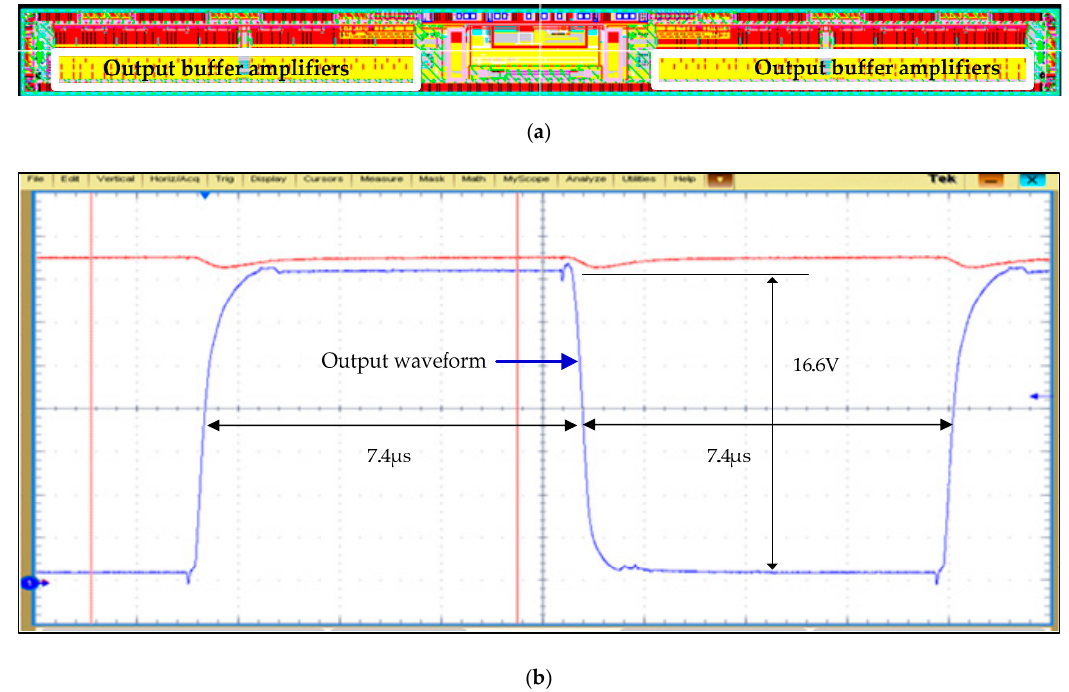
Figure 3. A column driver IC using the proposed output buffer amplifier. ( a ) Layout picture and ( b ) measured output waveform of the white pattern (VSS2 +0.2 V (0.2 V)—VDD − 0.2 V (16.8 V)) in the dot inversion.